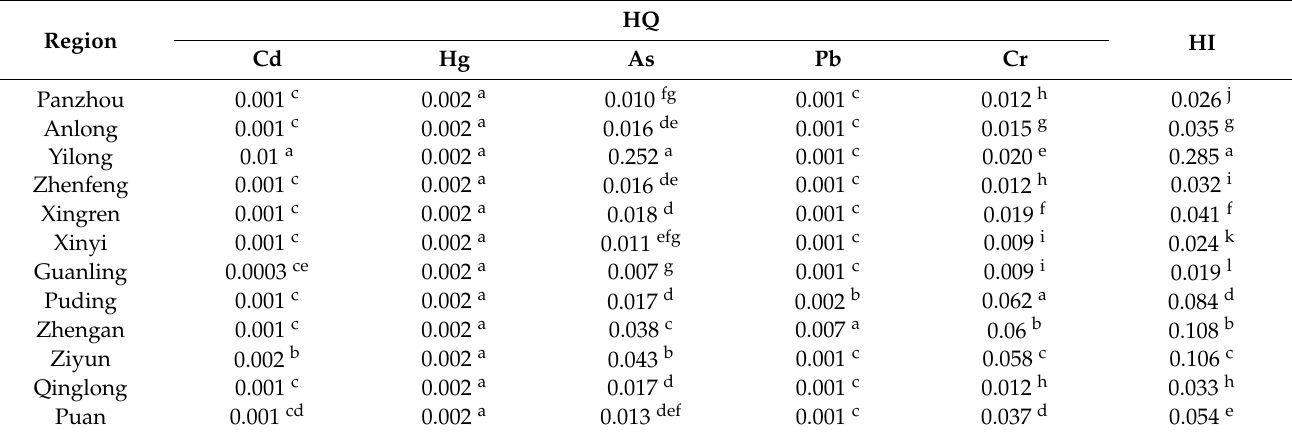
Table 5. The risk evaluation of heavy metals in coix seeds.